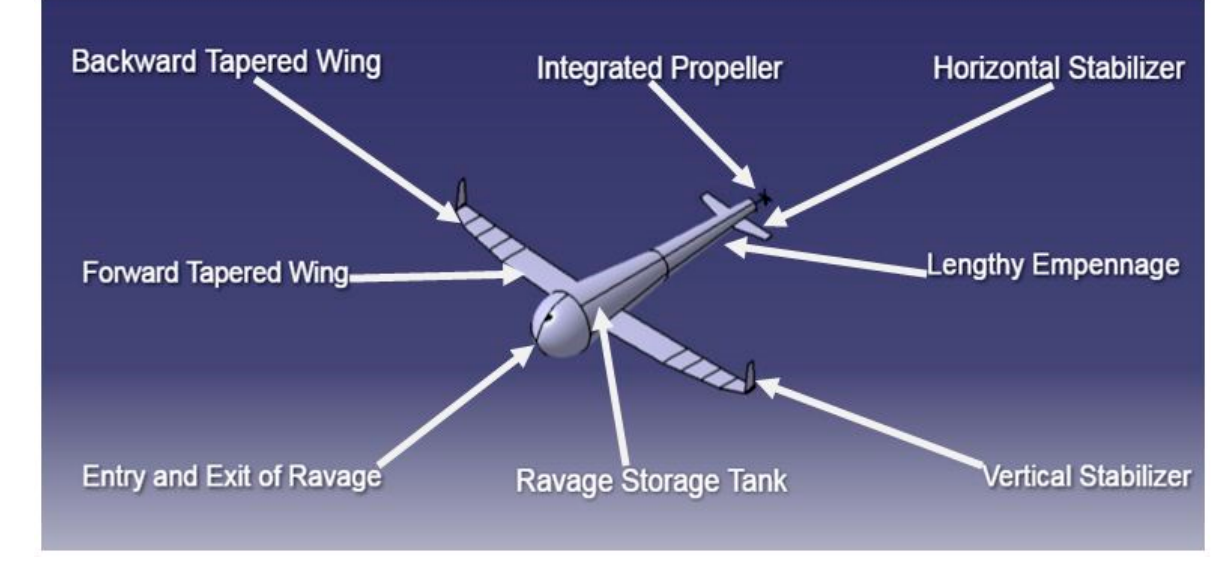
Figure 6. Design draft of the complete nature-based UAV—A typical view—1.